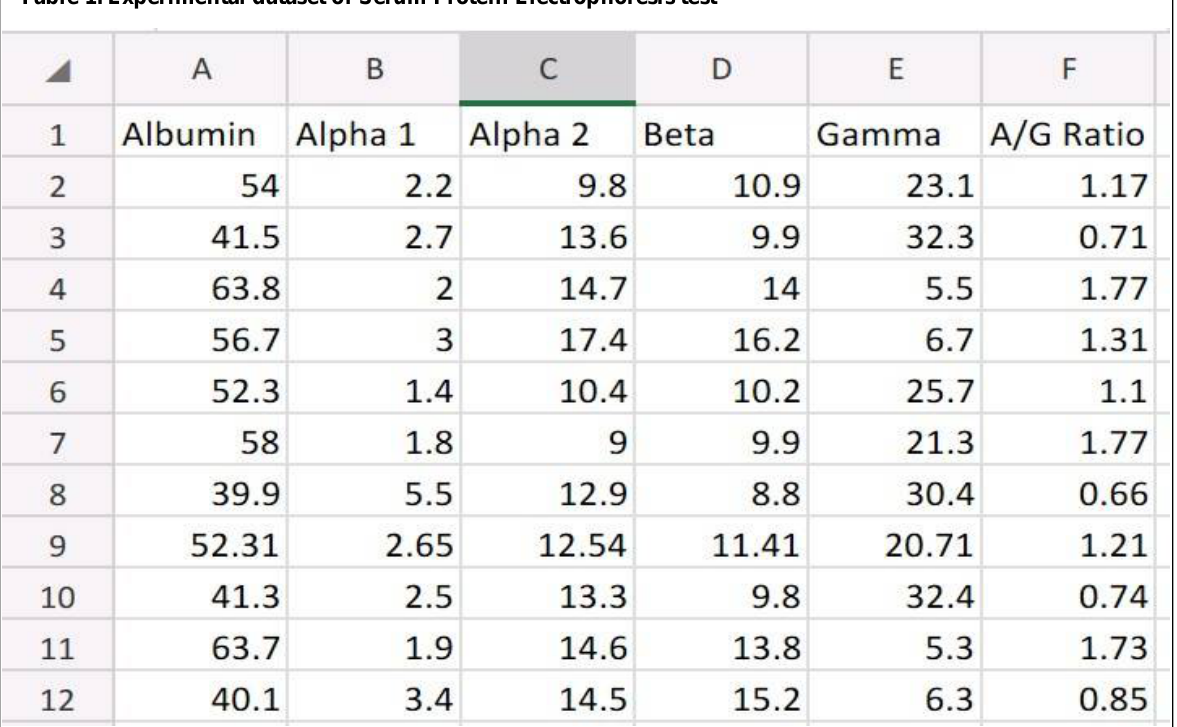
Table 1: Experimental dataset of Serum Protein Electrophoresis